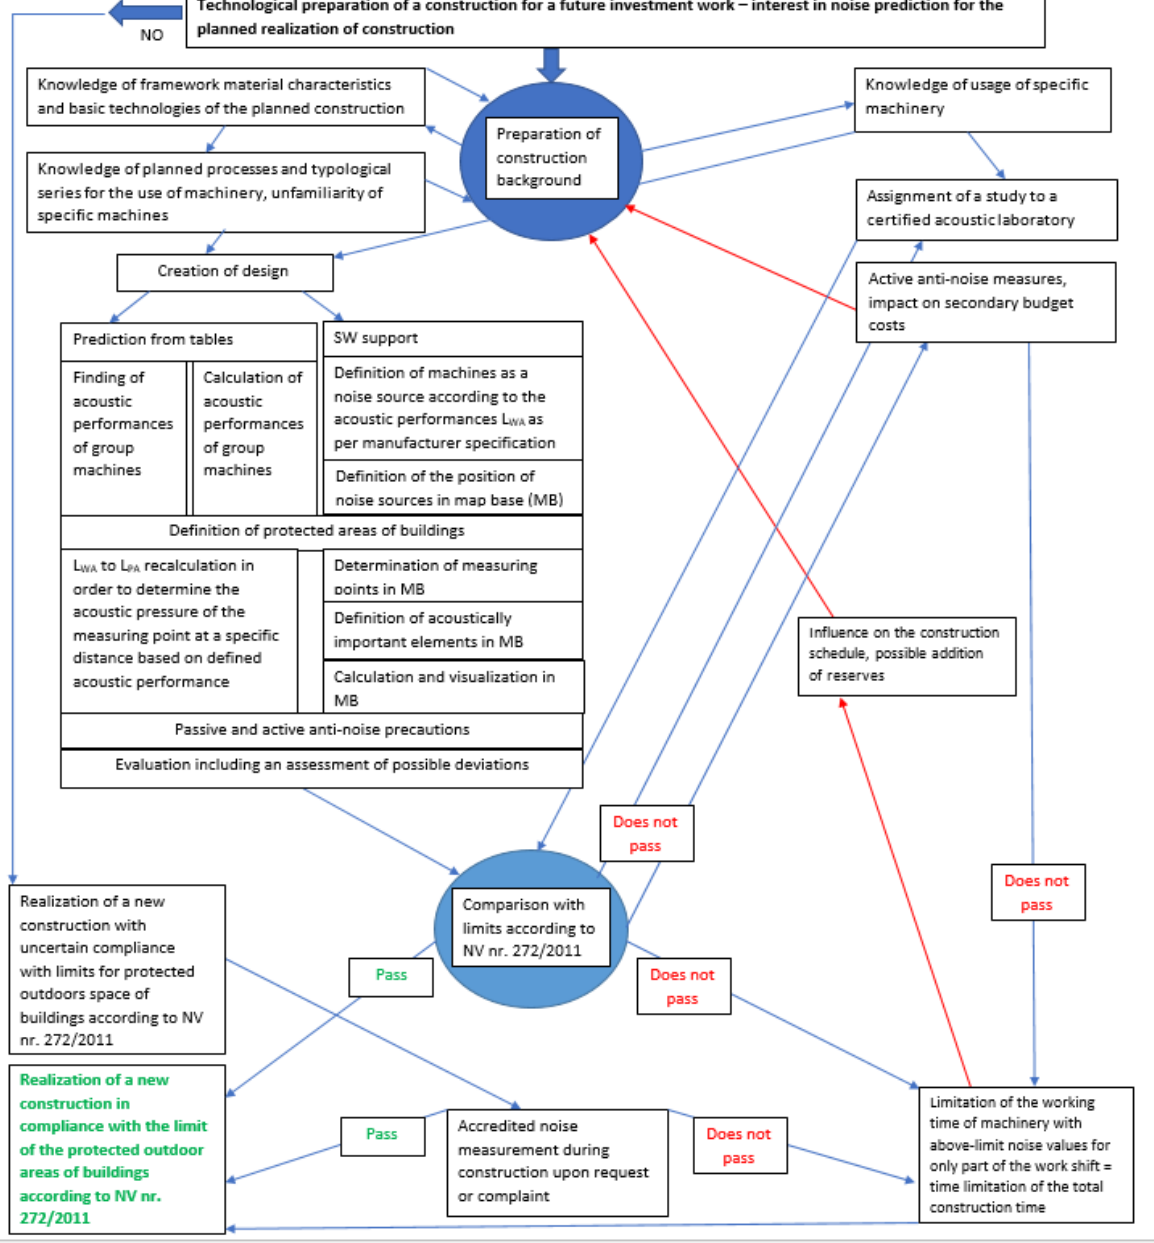
Figure 2. Methodology for noise prediction from construction activities.